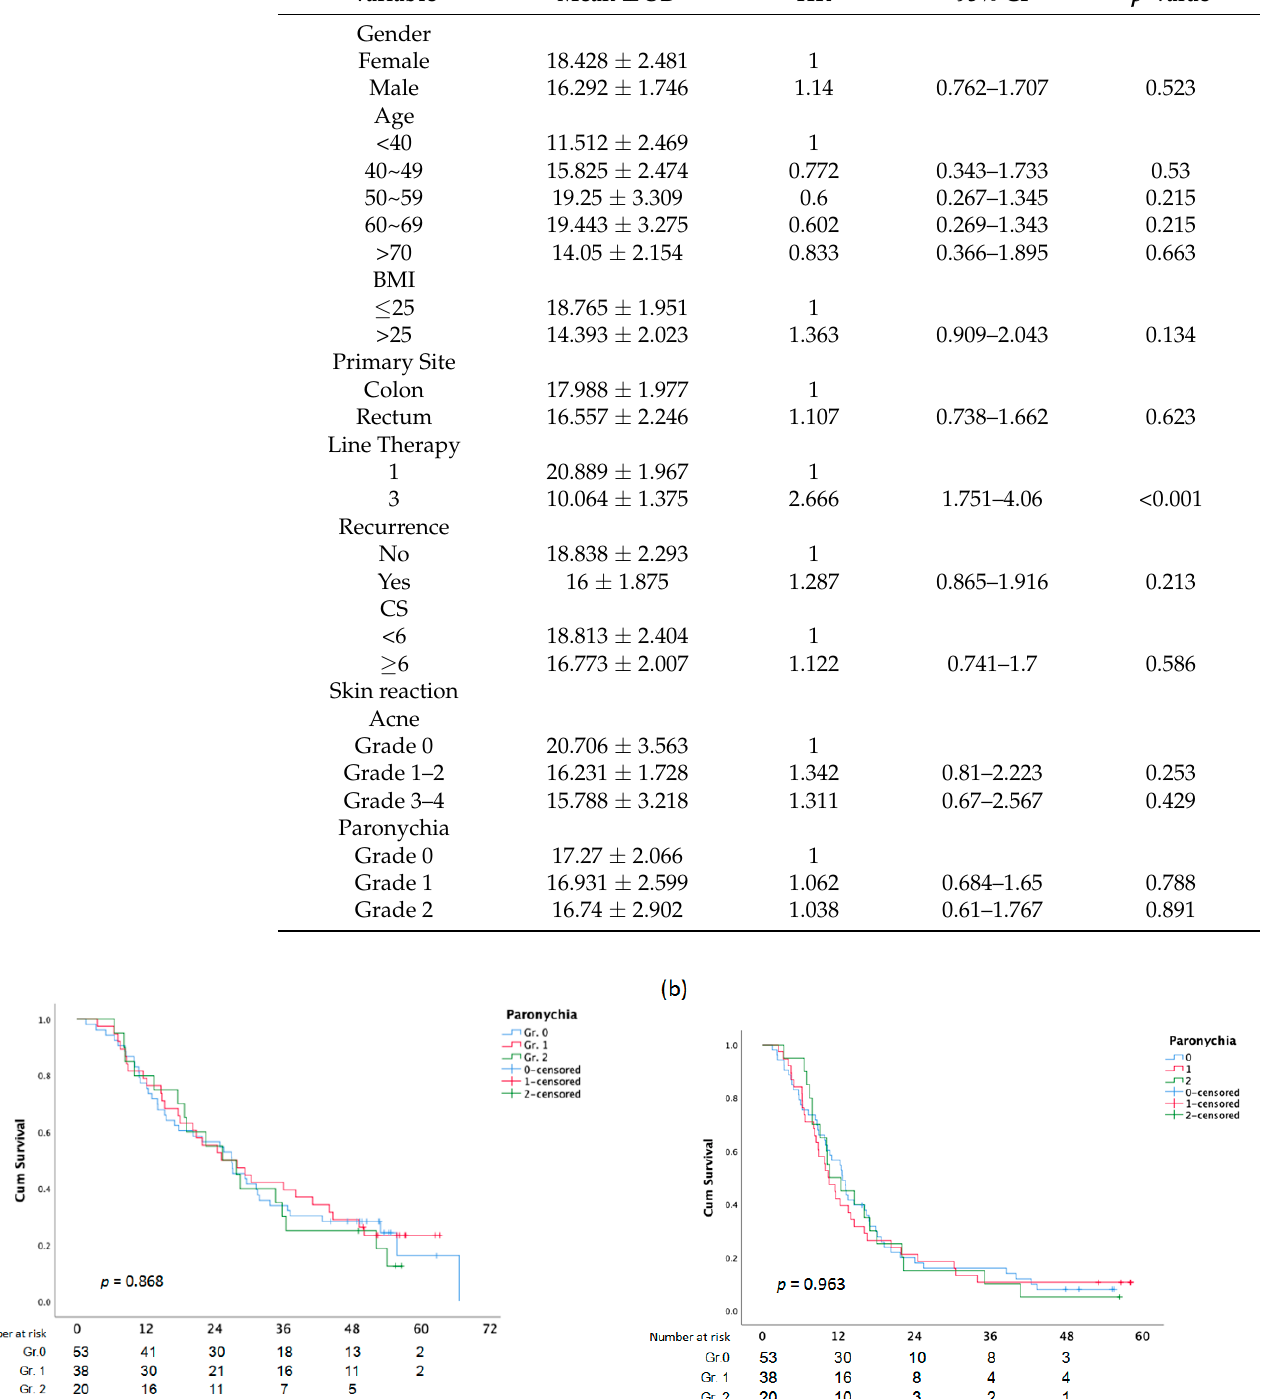
Figure 2. Overall Survival ( a )and PFS ( b ) analysis according to Paronychia. There was no statistically significant difference between OS and PFS and the assess- ment of the EGFR composite score, skin responses, and paronychia (Figure 3).